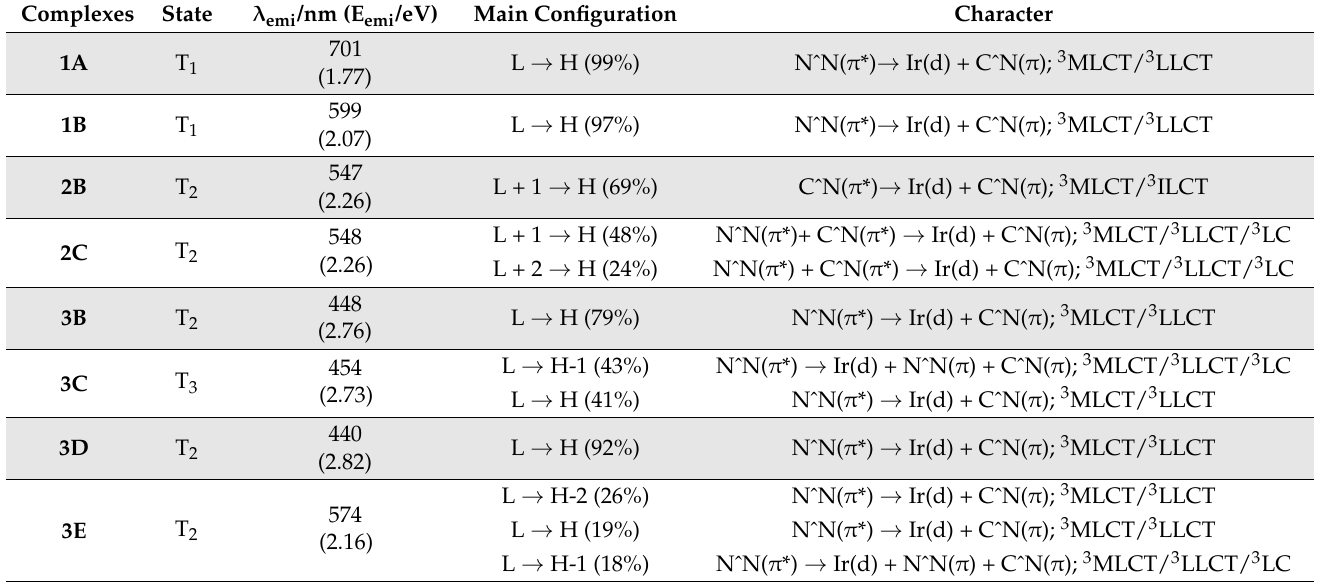
Table 3. Excited states properties of the Ir(III) complexes studied calculated from TD-DFT